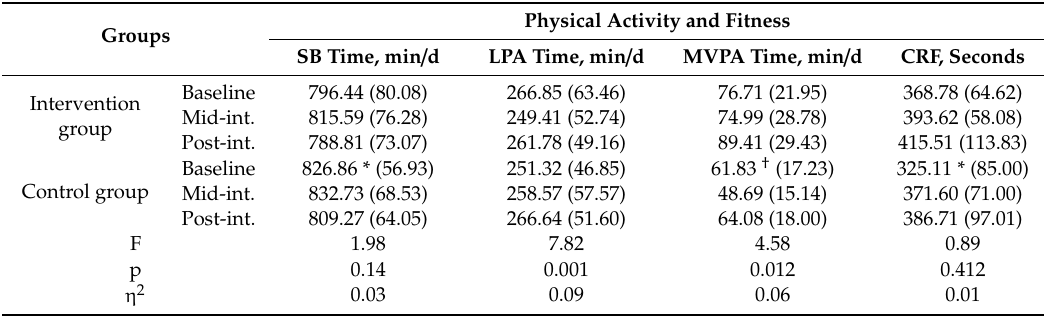
Table 2. Baseline, mid- and post-intervention physical activity and fitness descriptive and ANCOVAs using age and race as a covariate with repeated